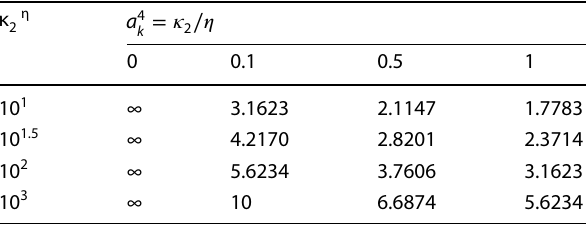
Table 2 Frequency parameter ( a